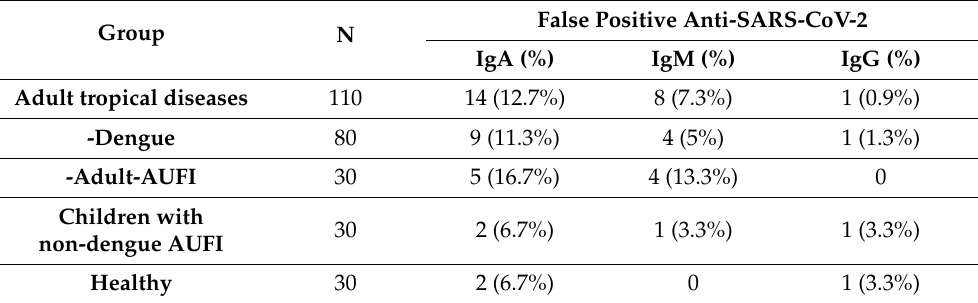
Figure 2. Anti-SARS-CoV-2 ELISA result distribution in each group. Analysis of anti-SARS-CoV-2 ELISA of IgA ( A ), IgM ( B ), and IgG ( C ) in serum samples from COVID-19, dengue, adults, and children patients with acute undifferentiated febrile illness (AUFI) and healthy persons. ns, non- significant; *, p < 0.05; ****, p < 0.0001.